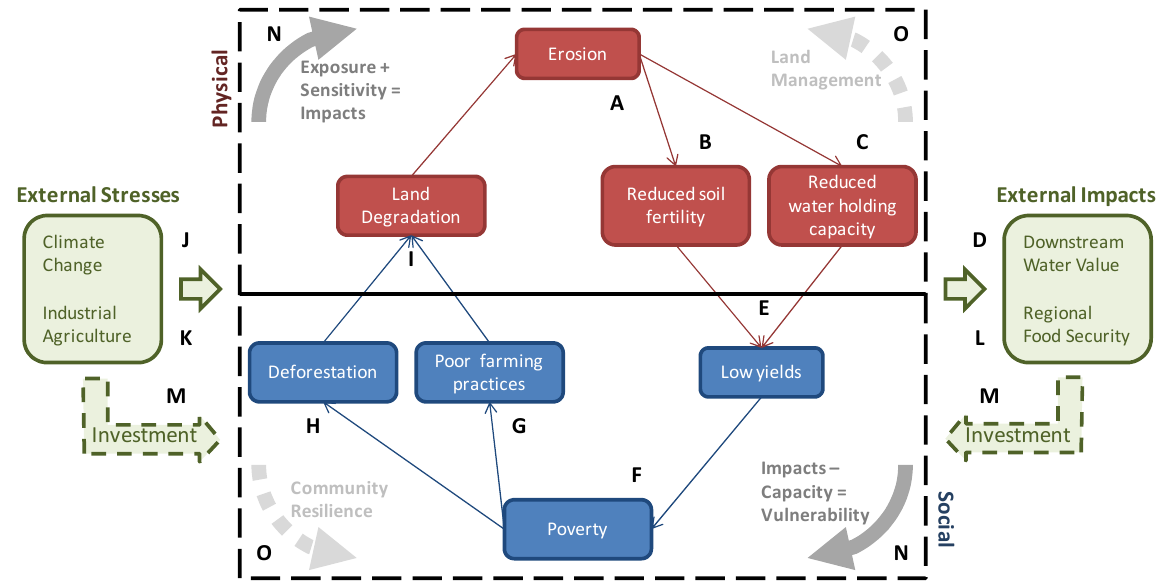
Figure 6. Framework for reversing coupled degradation-vulnerability processes in the context of climate